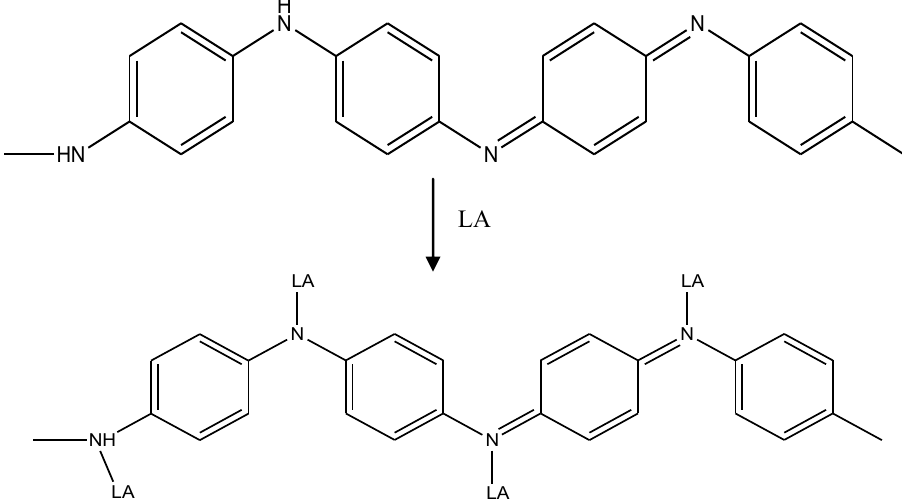
Figure 1. Chemical structure of Lewis acid (BF ) doped emaraldine base PANI. 3 Molecular structure of BF doped HPPANI was investigated by UV-Visible 3 spectroscopy and Fourier-transform infrared (FTIR) spectroscopy. UV-Visible absorption spectra for both undoped HPPANI and BF doped HPANI shown in Figure 2. Undoped 3 HPANI gives two electronic absorption bands at 330 nm and 630 nm approximately. The broad absorption feature at 630 nm has been assigned to quinoid formation in the backbone of the PANI, while the band at 330 nm is assigned to the π →π * electronics transition of benzenoid rings in the HPPANI. In case of BF doped HPANI, new absorption bands 3 appears at 450 nm and 830 nm. These features confirmed the BF doping to HPPANI. It is 3 important to note that the same changes have also been observed in the case of proton doped PANI 12-13